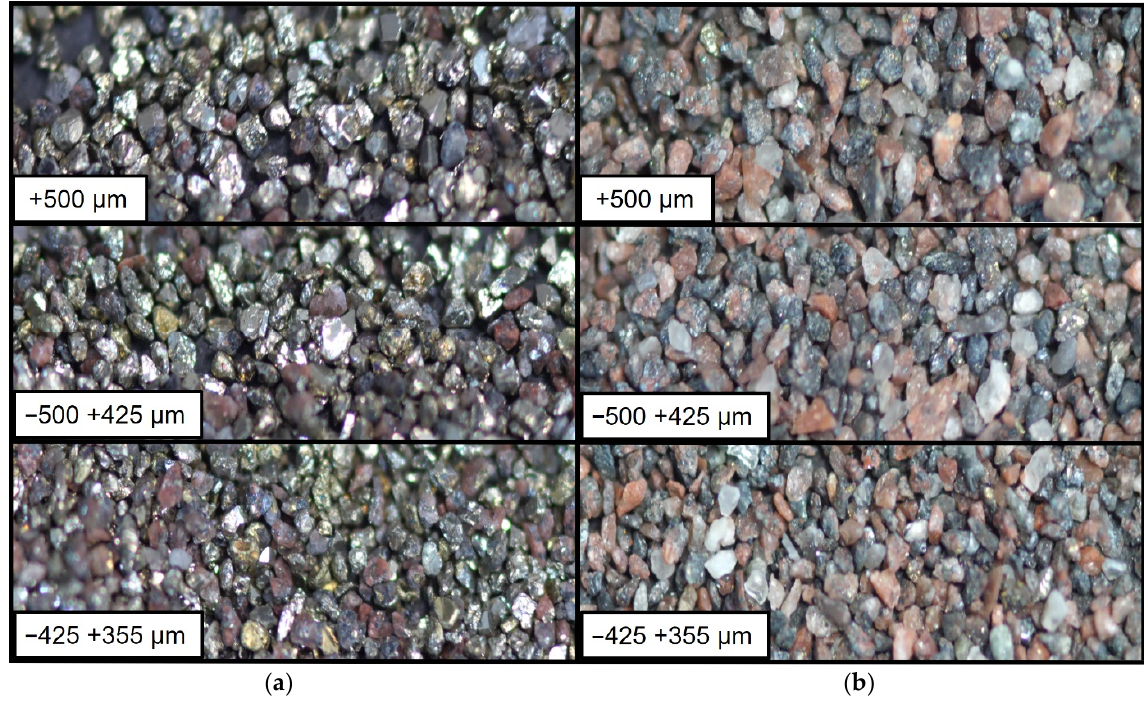
Figure 11. Images of the overflow product ( a ) and underflow reject ( b ) particles show the strong contrast in the surface lustre and hence surface liberation of the particles. Particles were taken from samples collected during Run 2-E (0.3 cm/s gas flux).